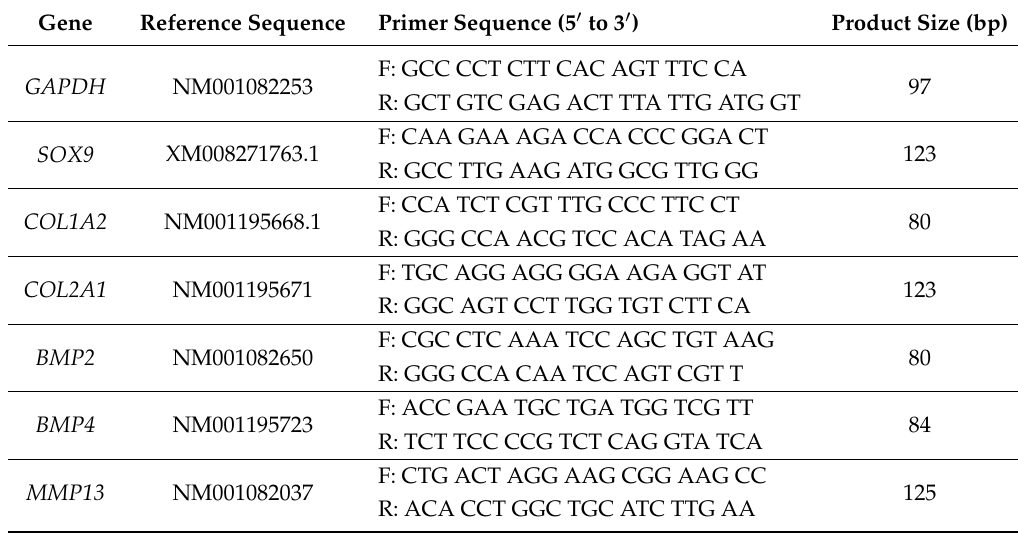
Table 1. A list of RT-qPCR primers and product sizes. (F = Forward, R =